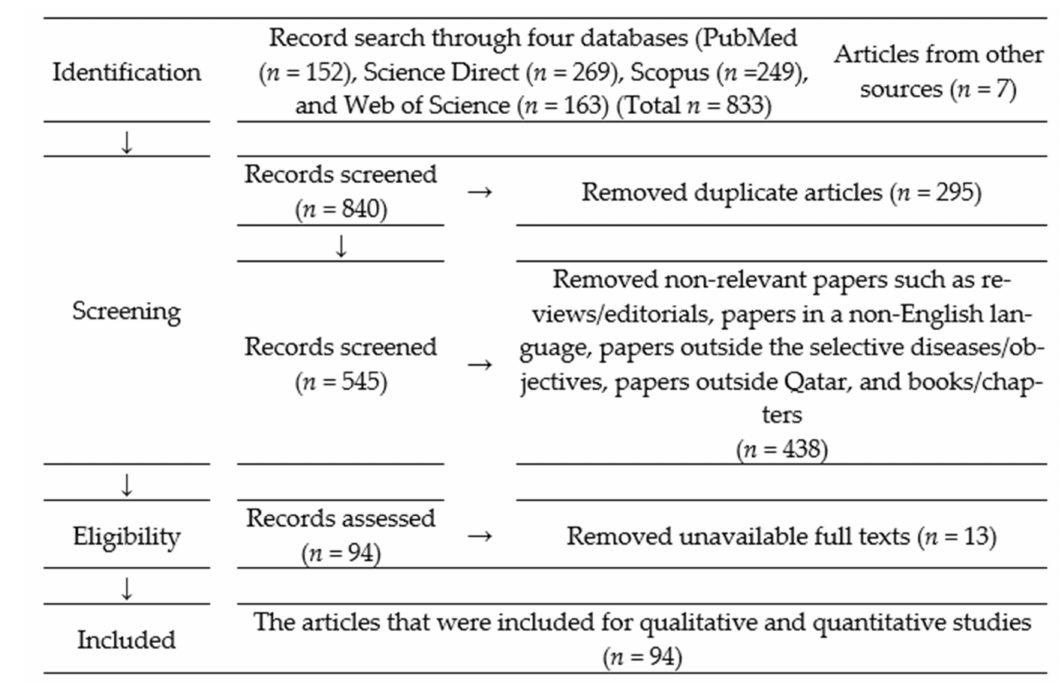
Figure 1. PRISMA flow diagram describing selection of published articles on rodent-related diseases with public health importance in Qatar and the inclusion/exclusion process used in the